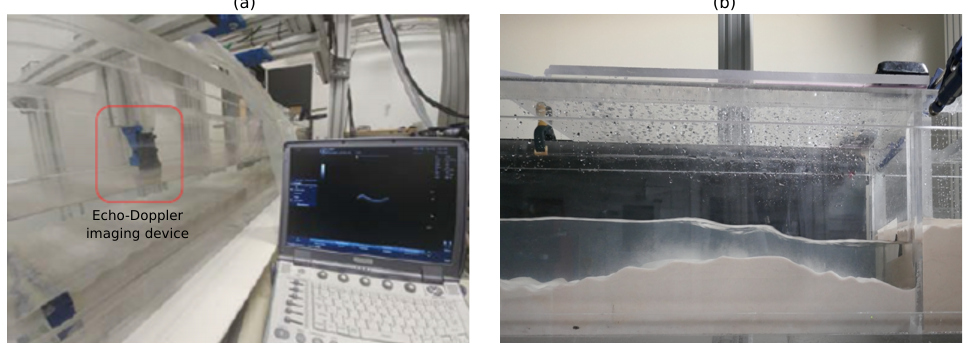
Figure 1. ( a ) Water/sediment bed interface monitored by the echo-Doppler a high-resolution echo- Doppler imaging device at the Laboratory for Hydraulic and Environment (LHE) of the Institut National de la Recherche Scientifique (INRS) in Québec, Canada. ( b ) Results of the water/sediment bed interface after some